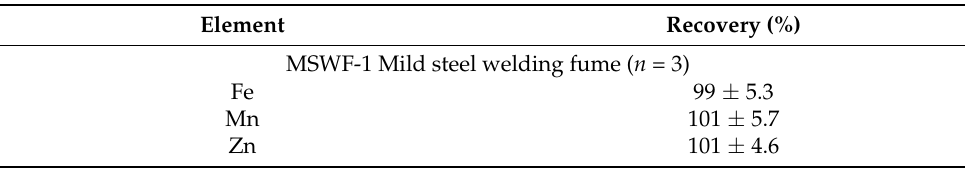
Table 2. Recovery (%) of mild steel welding fume reference